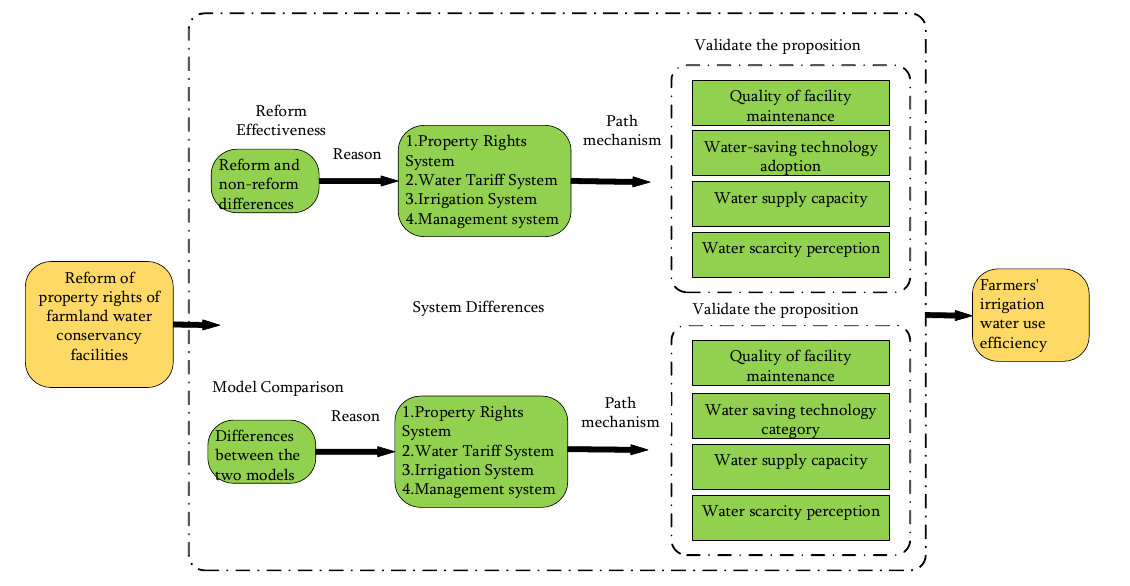
Figure 4. Theoretical mechanism framework of the impact of property rights reform of farmland water facilities on the irrigation efficiency of farming households. water facilities on the irrigation efficiency of farming